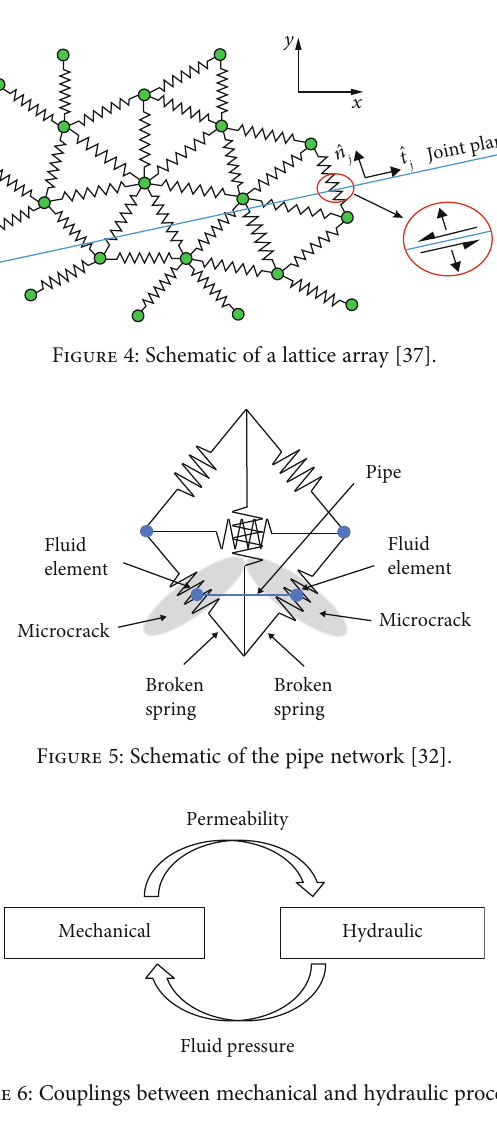
Figure 3: Schematic diagram of the synthetic rock mass (SRM) approach [21].